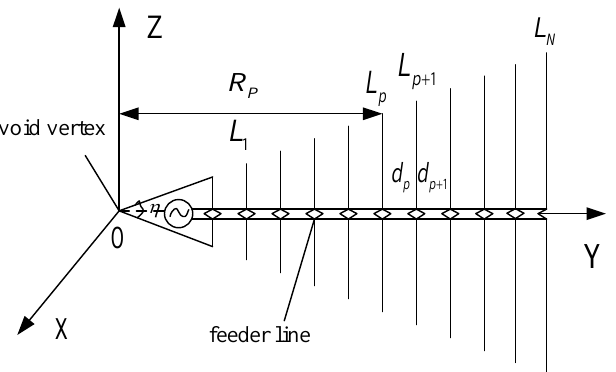
Figure 1. The structure diagram of LPDA.